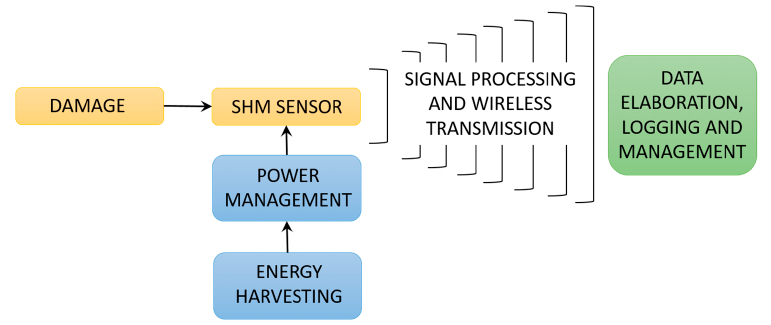
Figure 1. The ODIN SHM concept.